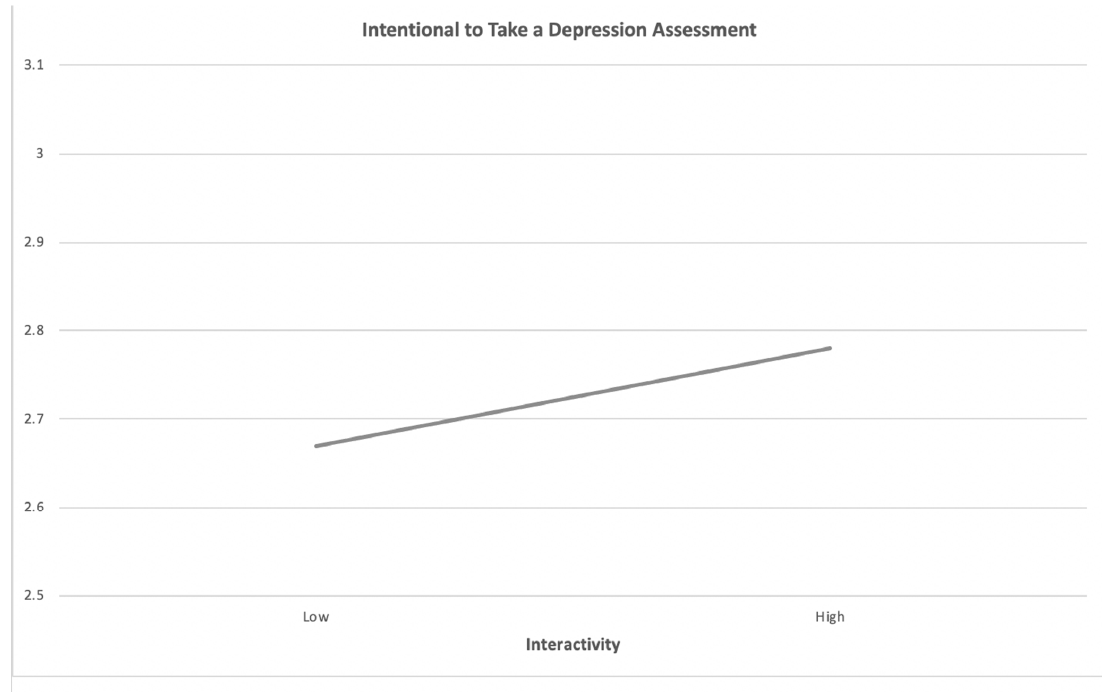
Figure 1. Main effect of framed messages on the intention to take a depression assessment (RQ1).